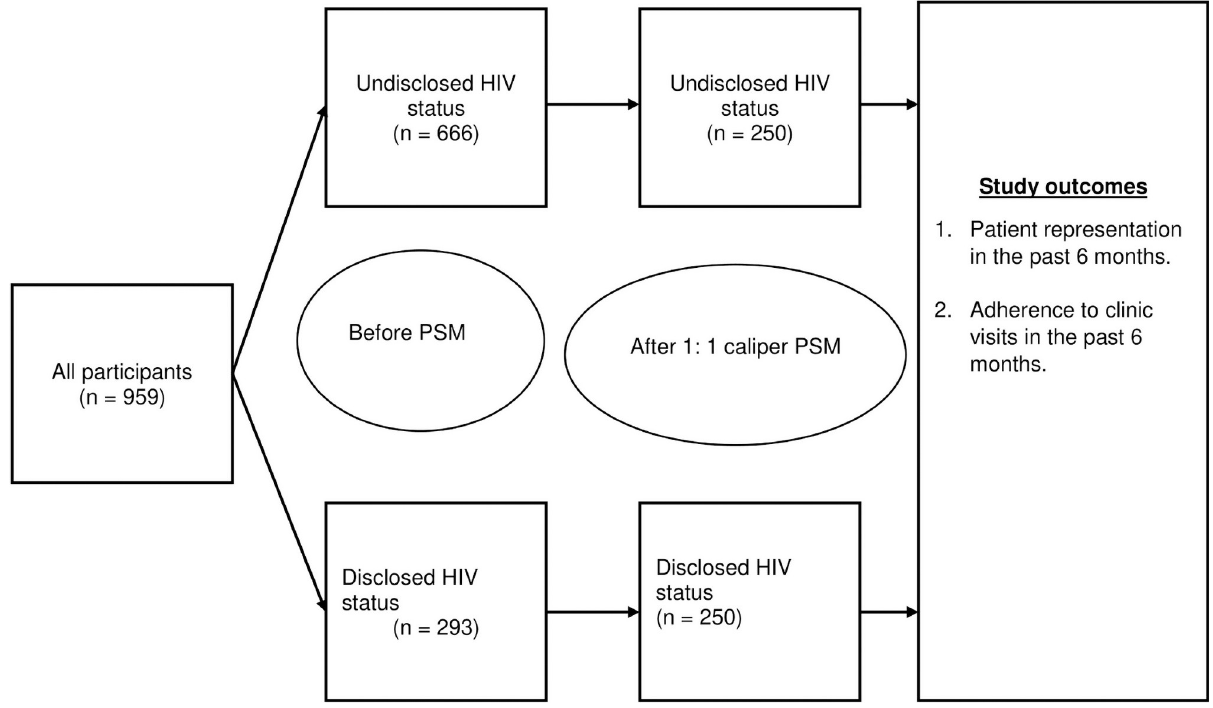
Fig 1. Study profile of HIV status disclosure before and after propensity score matching.